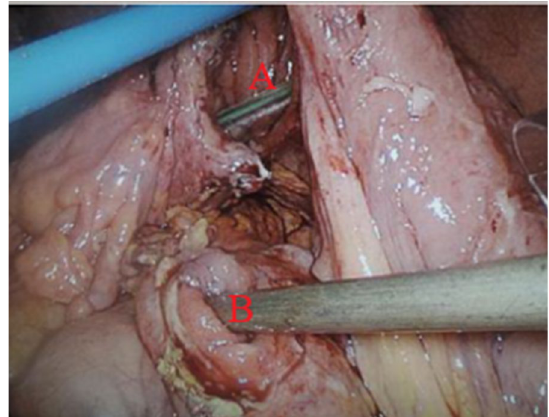
Fig. 1 Image of the perforation in the gastrojejunocolic fistula during the laparascopy in December 2018. The defect in the gastrojejunal anastomosis is shown in A . The defect in the transverse colon is shown in B